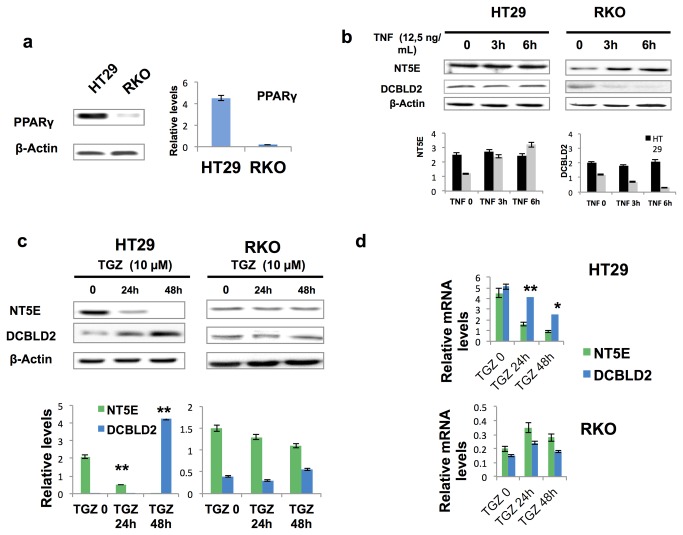
Cross-talk between TNF-α and PPARγ signaling regulates DCBLD2 and NT5E intracellular levels in CRC cell lines.
a. Western blotting analysis shows PPARγ expression in HT29 and RKO CRC derived cell lines, as a model to investigate variations of NTE5 levels in response to TNF-α treatment. b. PPARγ-dependent protein induction of NT5E by TNF-α in CRC cells treated with 12,5 ng/ml TNF-α at different time points and analyzed by western blotting. c and d. Time course of NT5E and DLBLC2 mRNA and protein regulation by troglitazone (TGZ), a PPARγ agonist, in the same cells. β-actin and Glyceraldehyde-3-phosphate dehydrogenase (GAPDH) were used as control to normalize expression levels in Western blotting and Real-time RT-PCR analysis. The results are expressed as means ±S.D. of three independent experiments. *
p < 0.05, **p < 0.01.